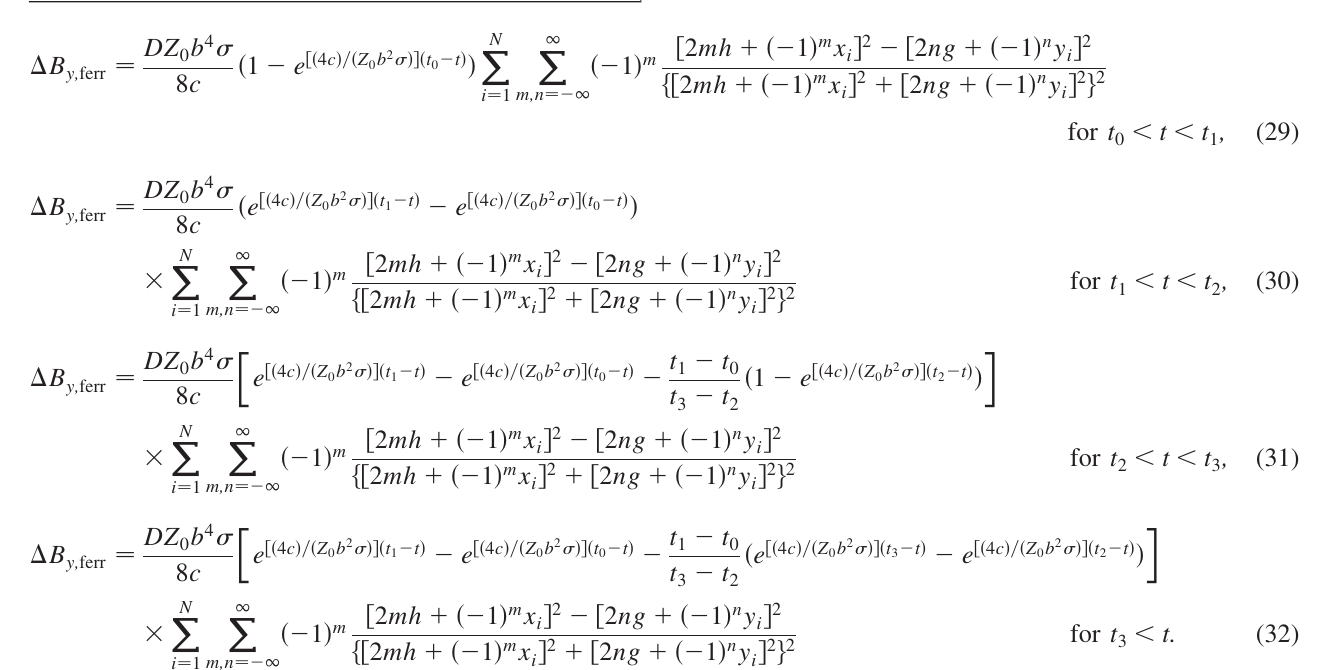
flattop time and damping time